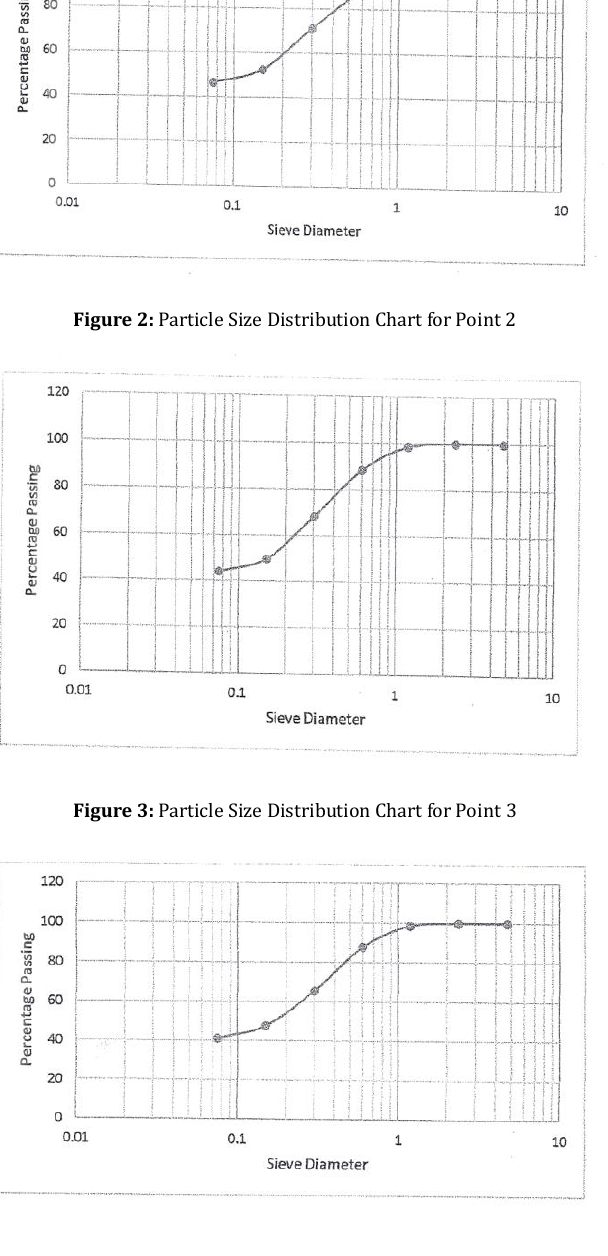
Figure 4: Particle Size Distribution Chart for Point 4